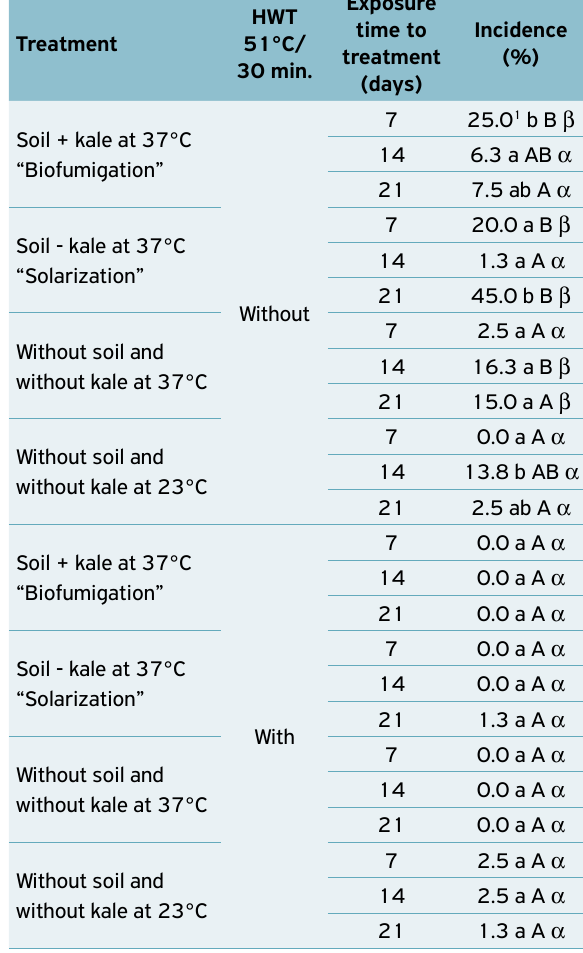
Lowercase letters: comparison of different periods by fixing the thermotherapy and treatment; Uppercase letters: comparison of treatments by fixing the thermotherapy and the period; Greek letters: comparison of thermotherapy by fixing the treatment and the period. The comparisons were done in accordance with the Goodman association test (GOODMAN, 1964; 1965) at 5% significance 1 Medium of 80 fragments analyzed.